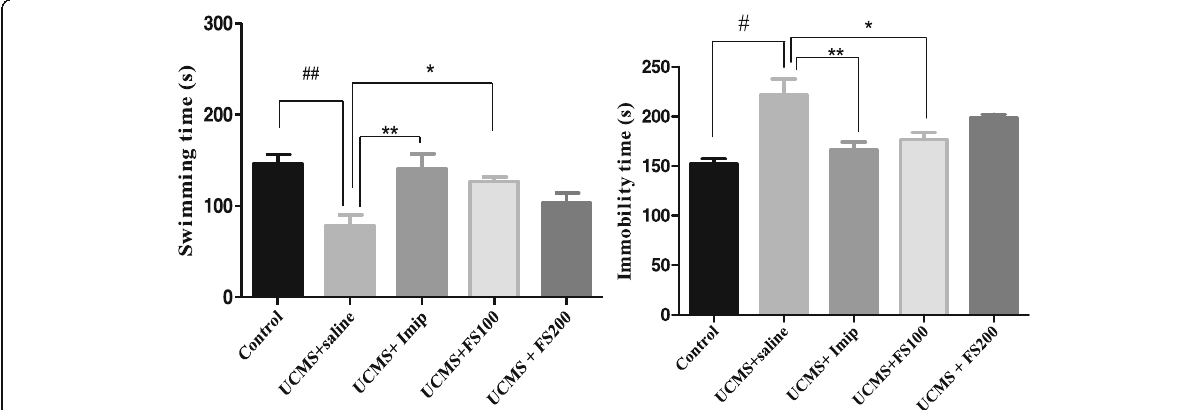
Fig. 7 Effect of the hydromethanolic extract of F. sycomorus on swimming and immobility time of rat before and after unpredictable chronic mild stress. UCMS: unpredictable chronic mild stress; Imip: imipramine, FS: F. sycomorus extract. # p <0.05; ## p <0.01 vs. control; *p<0.05; ** p<0.01; *** p <0.001